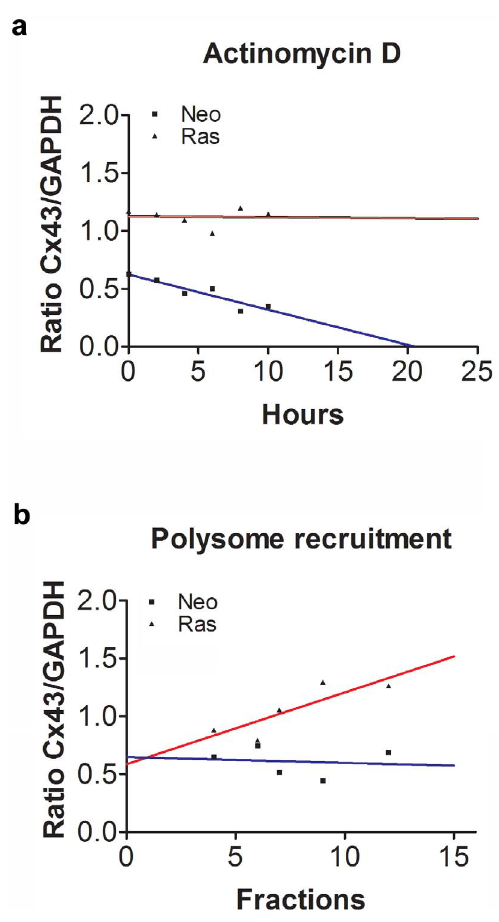
Figure 1. H-Ras regulates Connexin43 expression at post- transcriptional levels. a) RNA stability measured by the rate of Cx43 mRNA decay following inhibition of de novo transcription by actinomycin D. NIH-3T3 Neo and NIH-3T3 Ras cells were treated with actinomycin D (15 m g/ml), harvested at various time points and Cx43 and GAPDH mRNA levels were determined by RT 2 PCR. The values of Cx43/GAPDH mRNAs ratios are reported over the duration of treatment. The lines are based on a linear regression and indicate that there is a significant slope deviation from the zero for Neo (r=0.84; P =0.0095) versus Ras (r =0.0012; P= 0.94). b) Translation efficiency of the Cx43 mRNA. Polysomal and subpolysomal fractions were extracted from NIH- 3T3 Neo (Neo) and NIH-3T3 Ras (Ras) cells using a sucrose density gradient and the relative levels of Cx43 and GAPDH mRNAs in these fractions were determined by RT-PCR. The results are reported as a Cx43/GAPDH mRNA ratio in different fractions. The lines are based on a linear regression and indicate that there is a significant slope deviation from the zero for Ras (r =0.014; P =0.84) versus Neo (r =0.71; P =0.07).